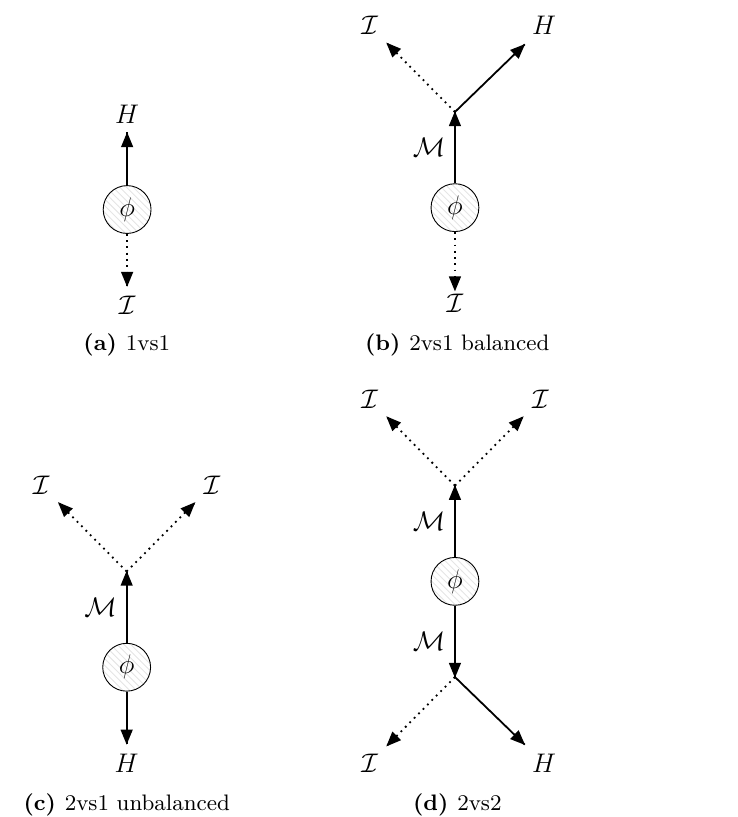
Figure 9. Sketch of an asymmetric neutral scalar boson φ decay in its rest frame leading to a mono-Higgs ( H ) plus E miss collider T